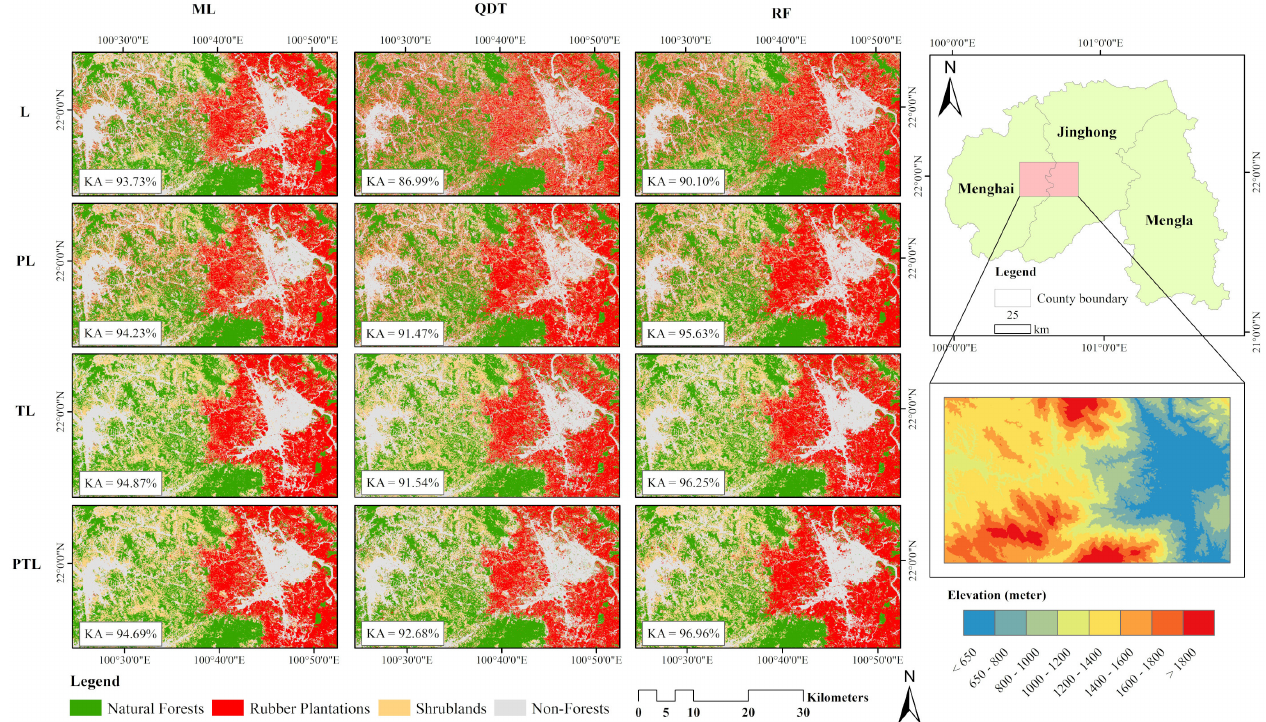
Figure 6. The classification results of three classifiers with four kinds of data input.